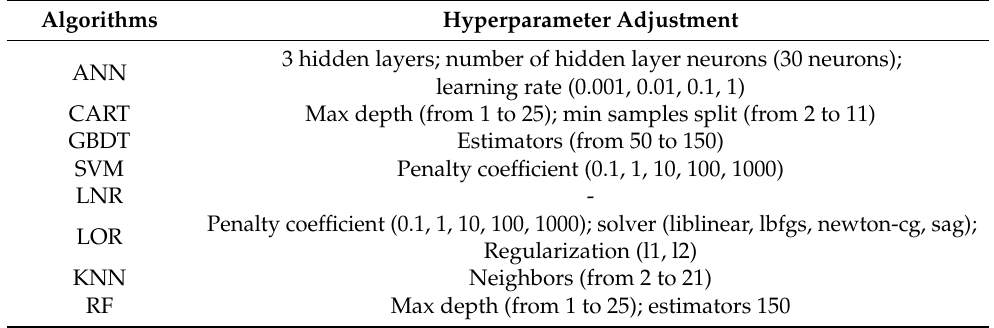
Table 2. Hyperparameter